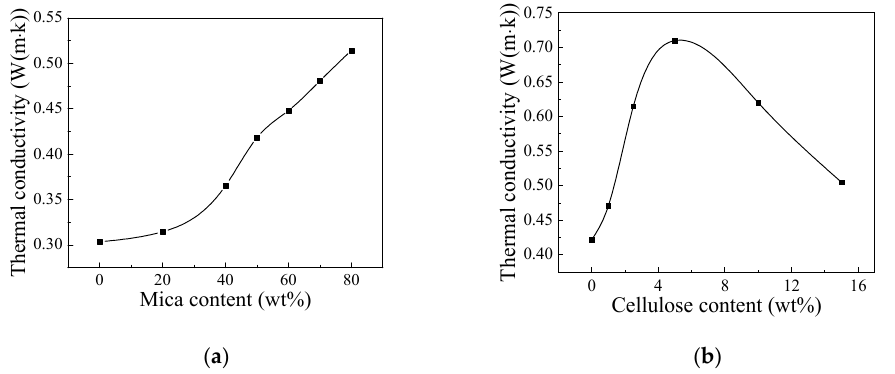
Figure 3. Thermal conductivity of the mica composites ( a ) and mica/chitosan/nanocelluloses composites ( b ).